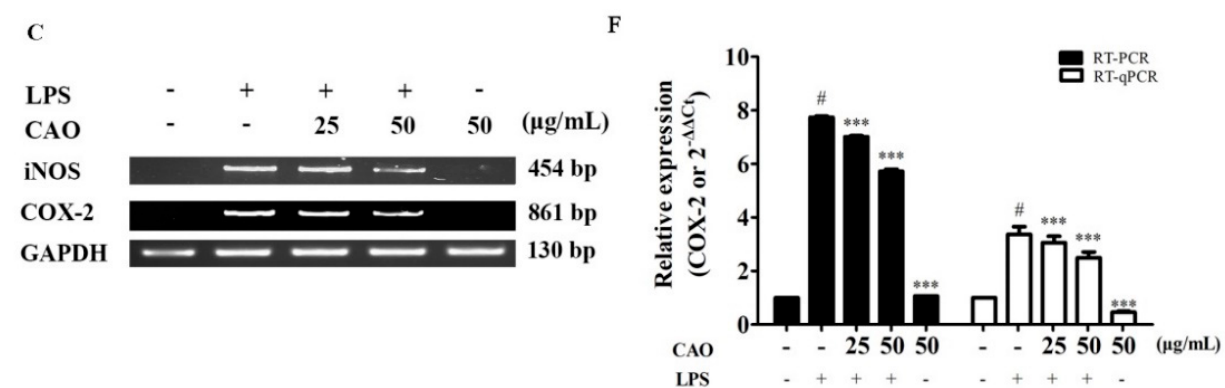
Figure 4. Effect of CAO on NO production, COX-2, and iNOS expression in macrophages. ( A ) released NO production to the medium was evaluated using a Griess reagent assay. ( B ) The expressions of COX-2 and iNOS protein were subjected to immunoblotting. ( C ) The COX-2 and iNOS mRNA levels were subjected to RT-PCR. ( D ) The bar graphs of the protein expression. ( E ) The bar graphs of RT-PCR and RT-qPCR for iNOS. ( F ) The bar graphs of RT-PCR and RT-qPCR for COX-2. Data are expressed as the mean ± SD ( n ≥ 3). # p < 0.001 vs. non-treated cells. ** p < 0.01, *** p < 0.001 vs. LPS-treated cells. NO = nitric oxide; CAO = callus of A. distichum var. Okhwang 1.